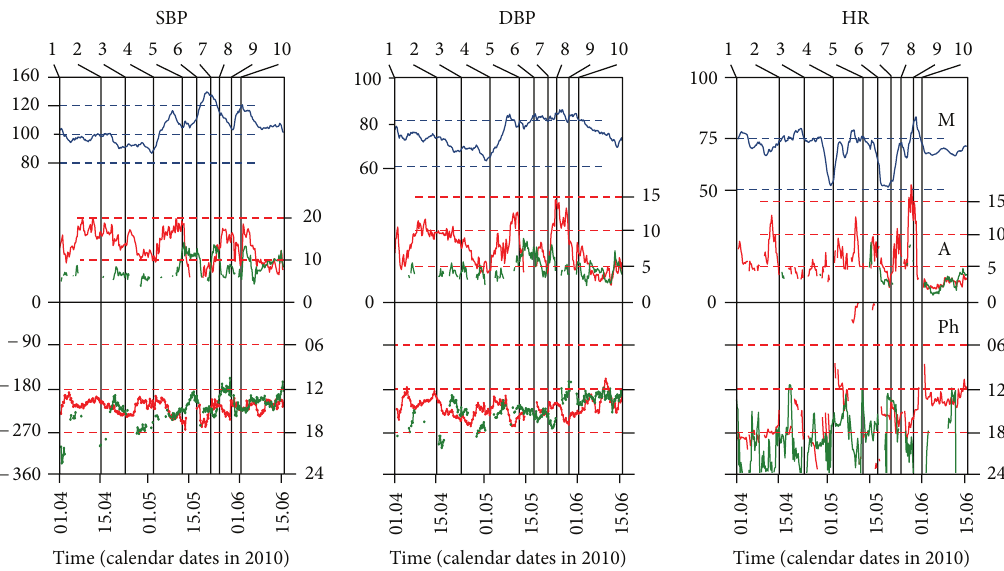
Figure 1: 24- and 12-hour rhythms of cardiovascular functions during heart failure development and treatment. SBP: systolic blood pressure, DBP: diastolic blood pressure, HR: heart rate. Blue curves: daily mean values, red: 24-hour rhythm parameters, and green: 12-hour rhythm parameters. Rhythm parameters: M: mesor, A: amplitude, and Ph: acrophase. Abscissae: above: stages of development (according Table 1), below: calendar time (dates in 2010). Ordinates: upper row left: BP or HR values (mmHg, beats/min), upper row right: amplitudes (same units of measurements), lower row left: acrophases (degrees of cycle), and lower row right: acrophases of 24-hour rhythm (clock